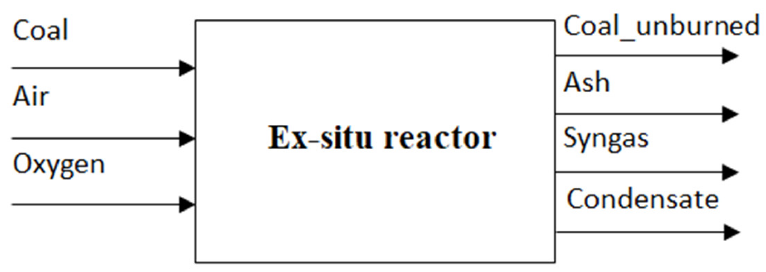
Figure 6. Scheme of the material balance in the ex-situ reactor.